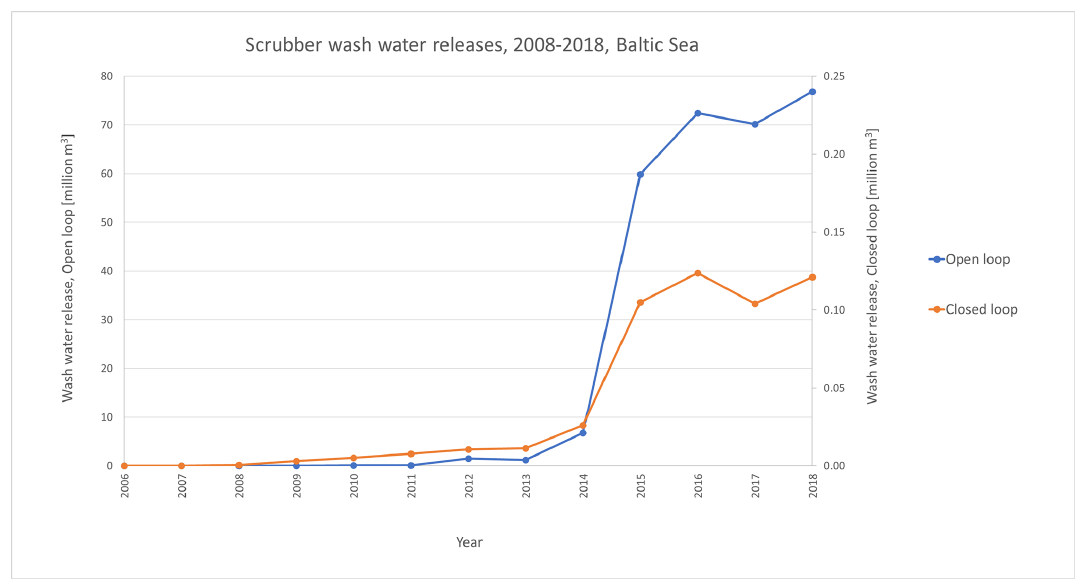
Figure 7. Scrubber effluent discharge from the Baltic Sea fleet during 2006–2018. Image taken from HELCOM discharge report